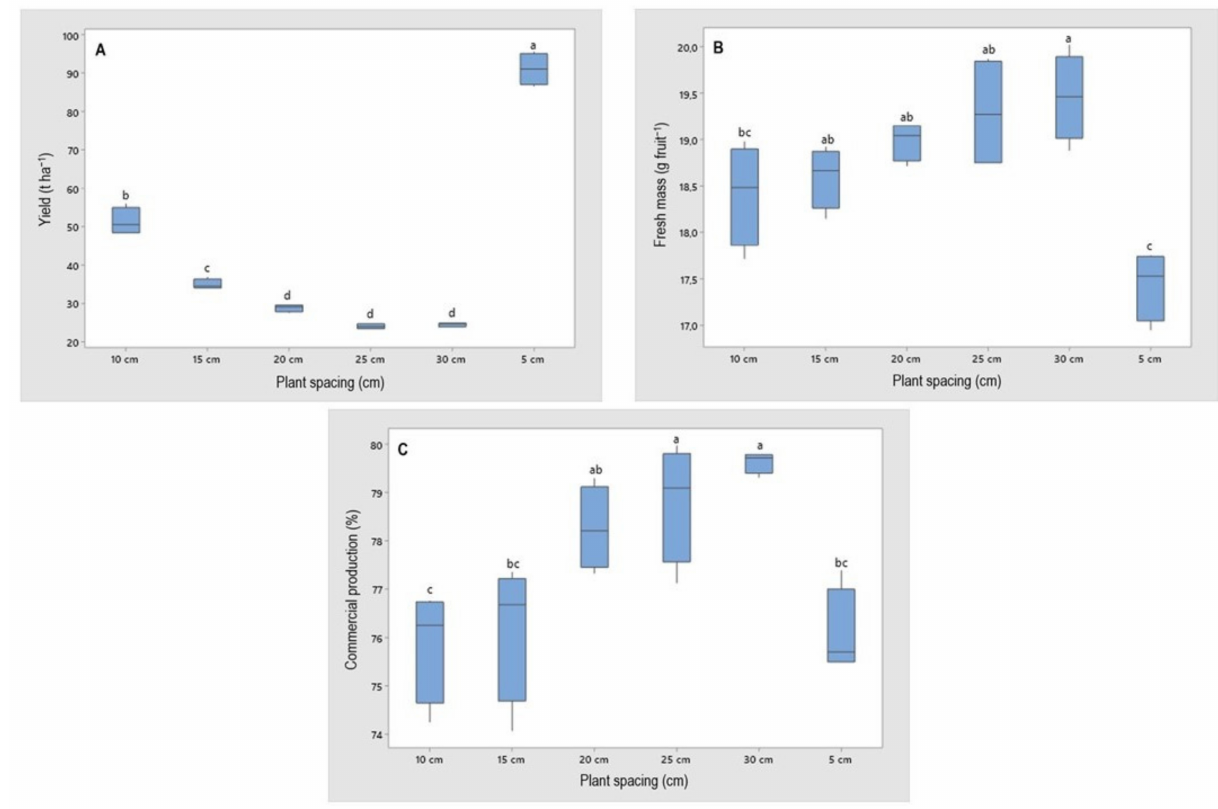
Figure 3. Yield ( A ), fresh fruit mass ( B ), and percentage of commercial production ( C ) of strawberry fruit cv. ‘Pircinque’ depending on the different spacing between plants with average of the 2018/2019 and 2019/2020 harvests. For each spacing, the different letters indicate significant differences ( p ≤